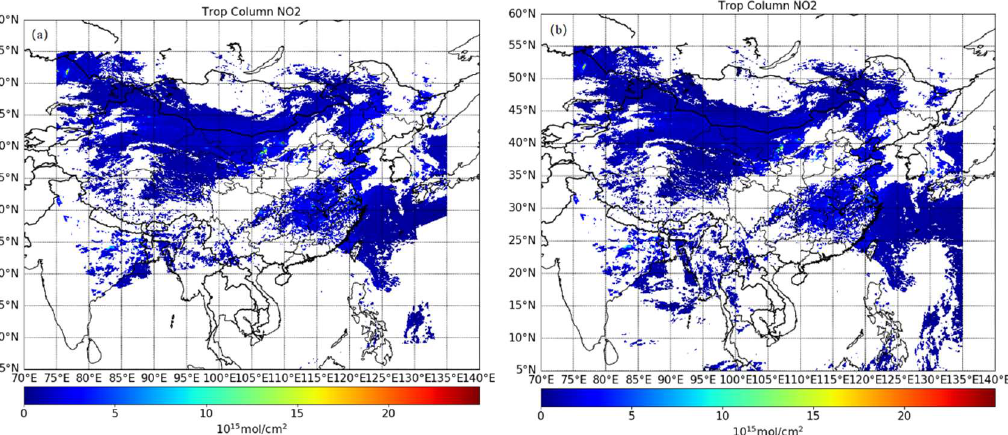
Figure 4. TropOMI tropospheric NO 2 column distribution in China on 16 August 2019: ( a ) near-real-time data; ( b ) offline data. Table 4. Statistic comparison of TropOMI’s two types of tropospheric NO 2 column products.